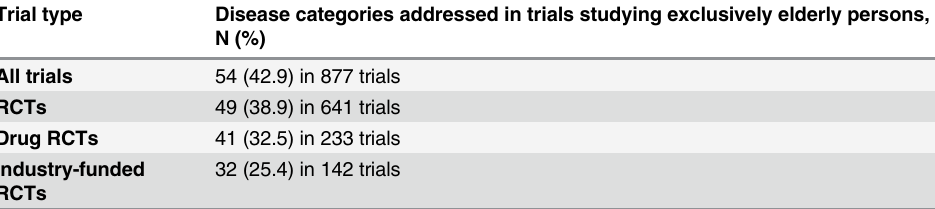
Table 3. Number of disease categories addressed in trials studying exclusively elderly persons across a total of 126 categories.